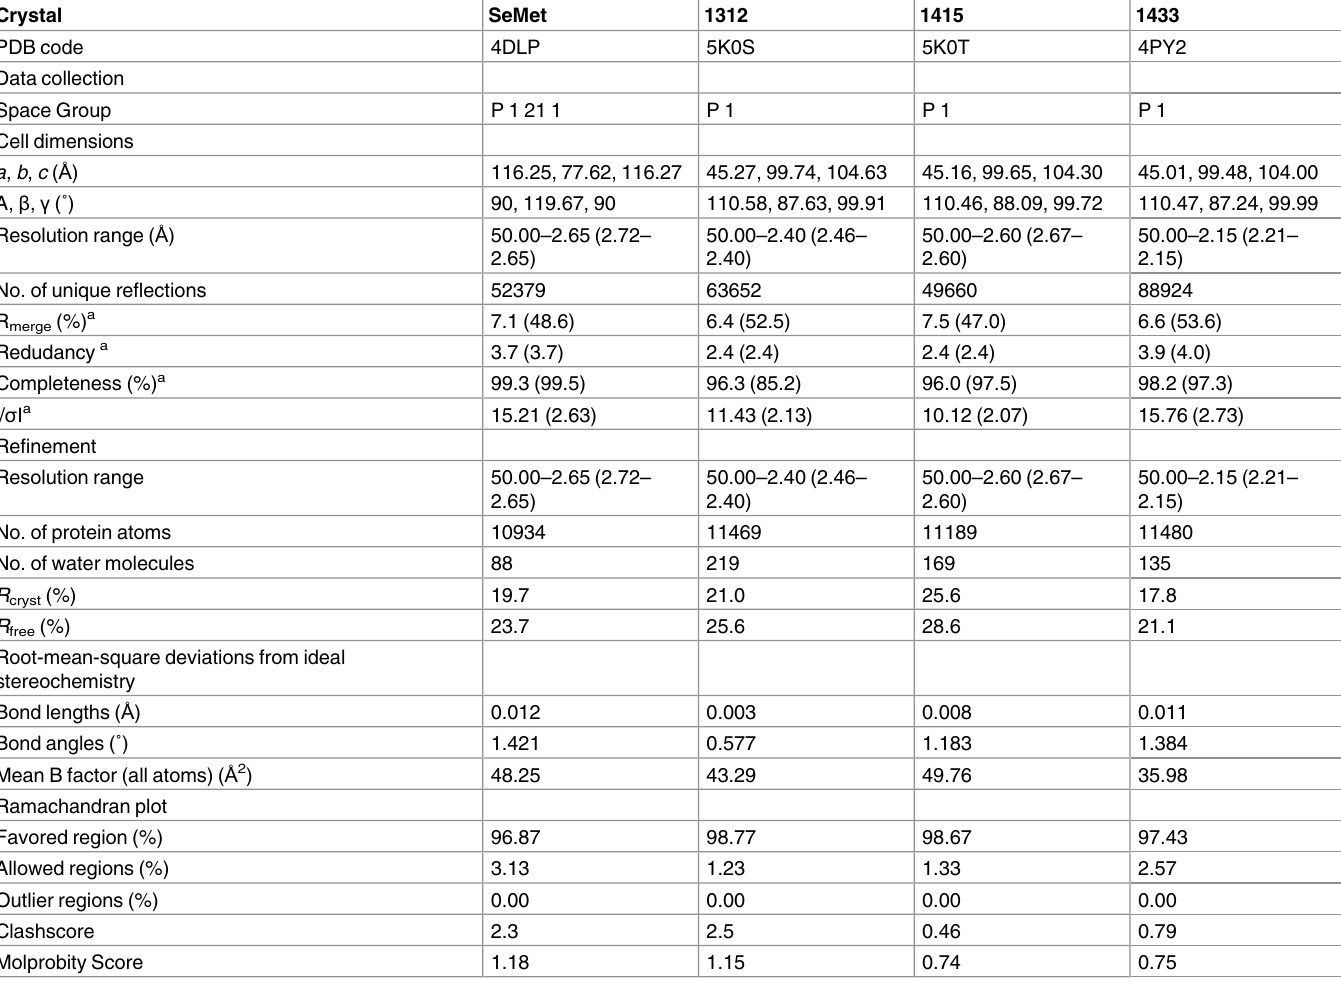
Table 2. Data collection and model refinement